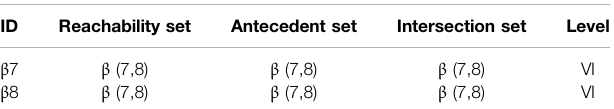
TABLE 12 | Partition level